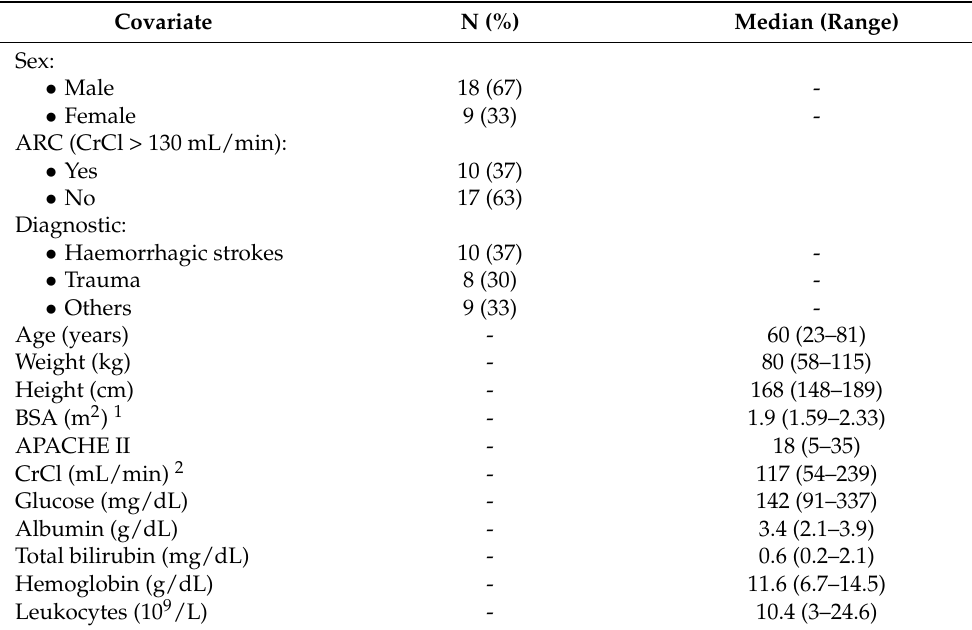
Table 1. Characteristics of the population included in the